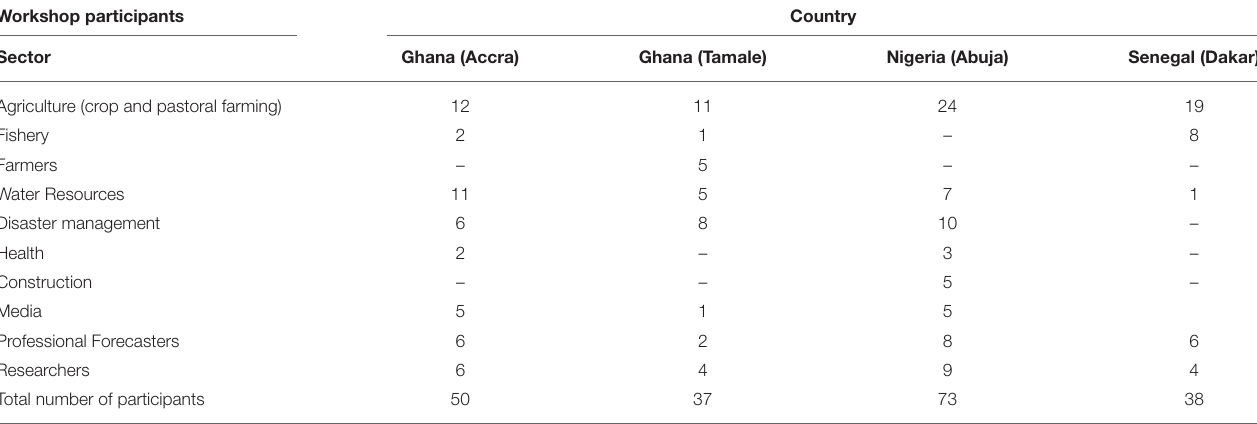
TABLE 1 | Summary of workshops participants per sector and